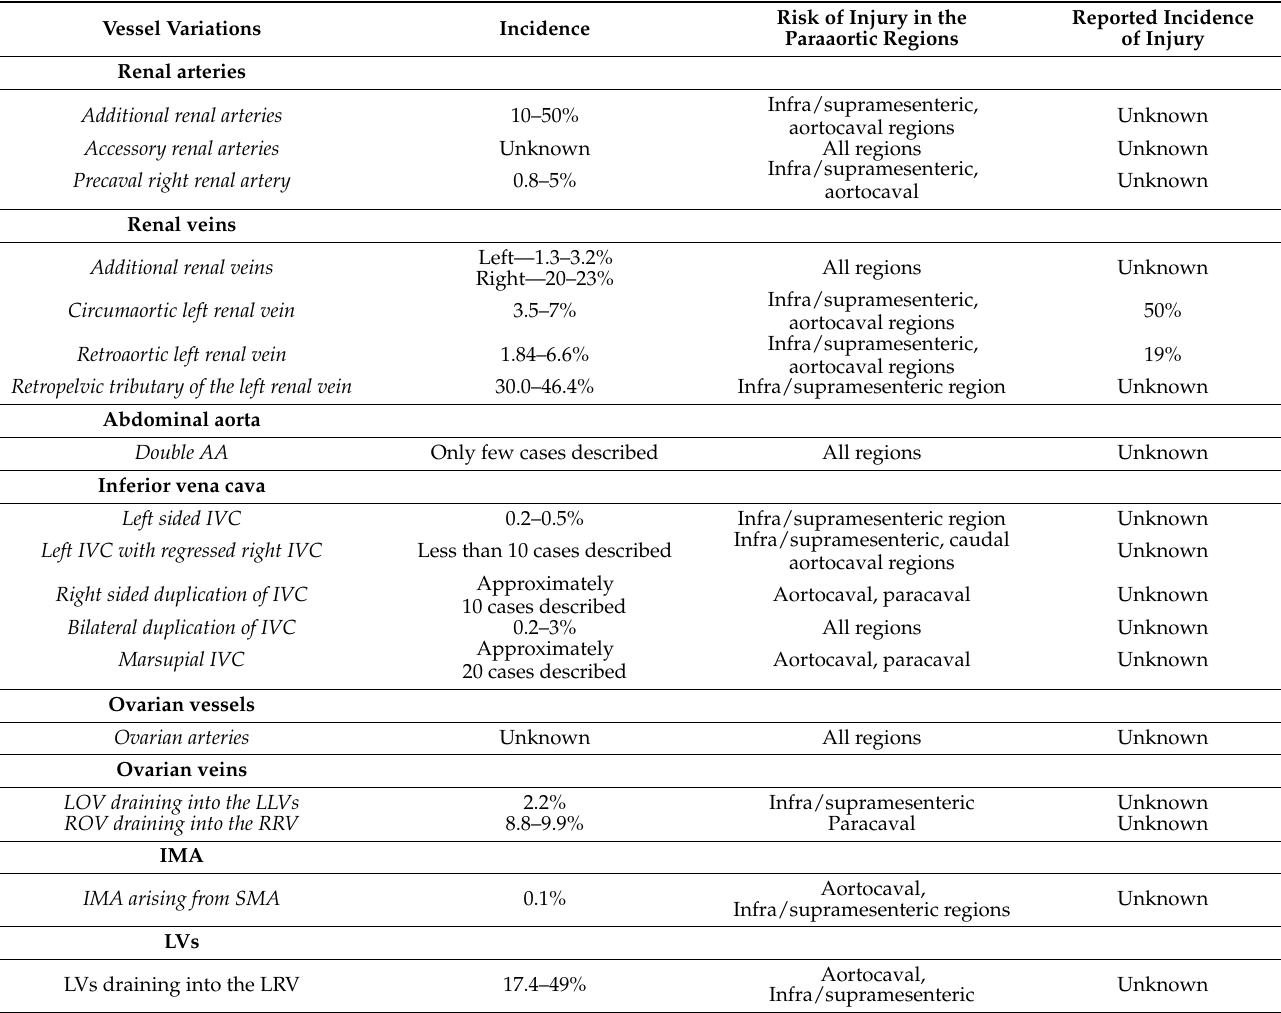
Table 1. Vessel variations in the paraaortic regions. AA—abdominal aorta, IVC—inferior vena